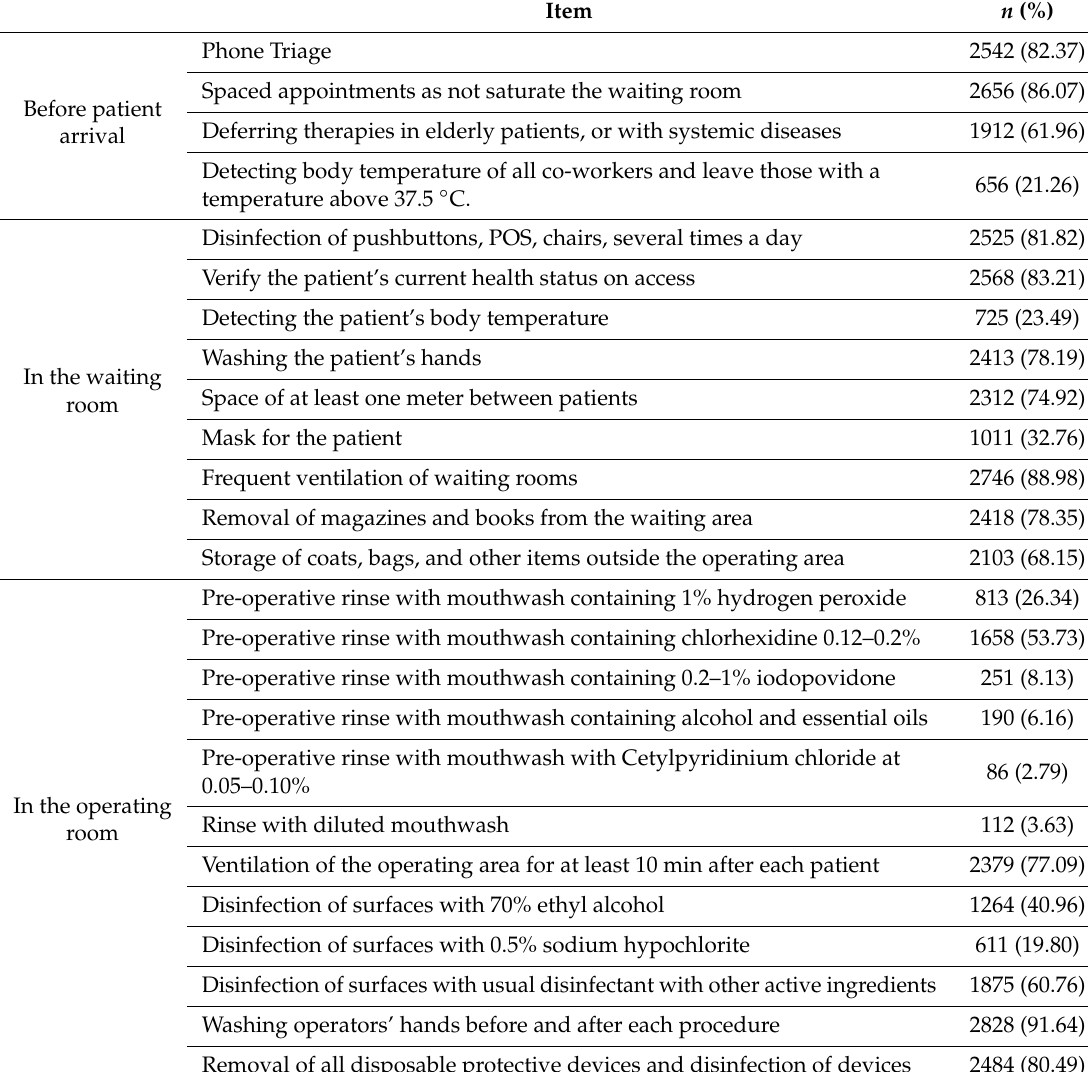
Table 5. Precautionary measures taken by dentists that continued to work after the outbreak of